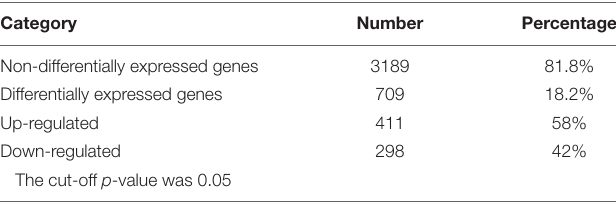
TABLE 1 | Number of genes that were differentially expressed after 10 min of exposure to 100 µ M Pd.